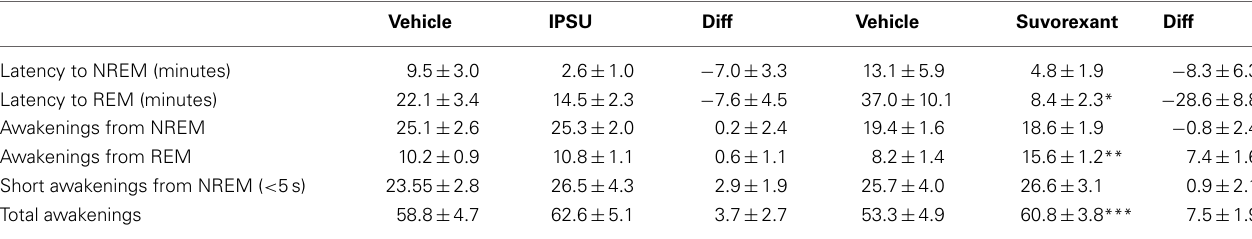
Table 1 | Effect of the OX 2 R preferring antagonist IPSU and the DORA, suvorexant on latency to sleep and sleep to wake transitions during the first 2h after administration during the inactive